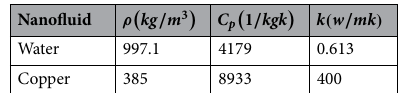
Table 1. Some physical features of Copper & water 1